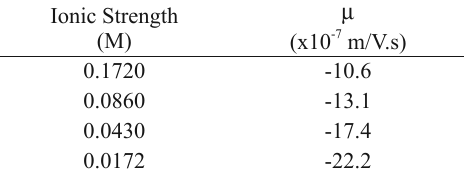
Electrophoretic Mobility versus Ionic